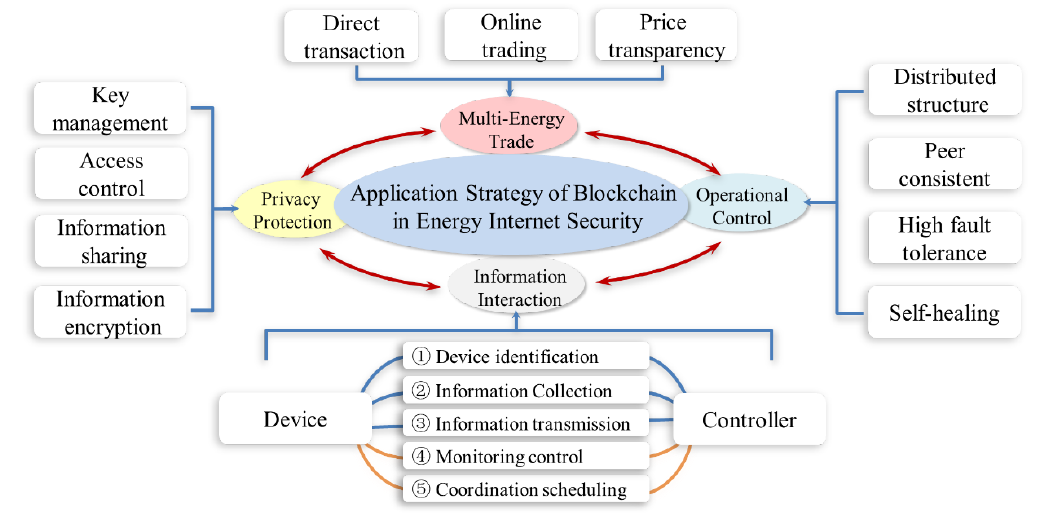
Figure 6. Illustration on the application of blockchain technology in the energy internet.